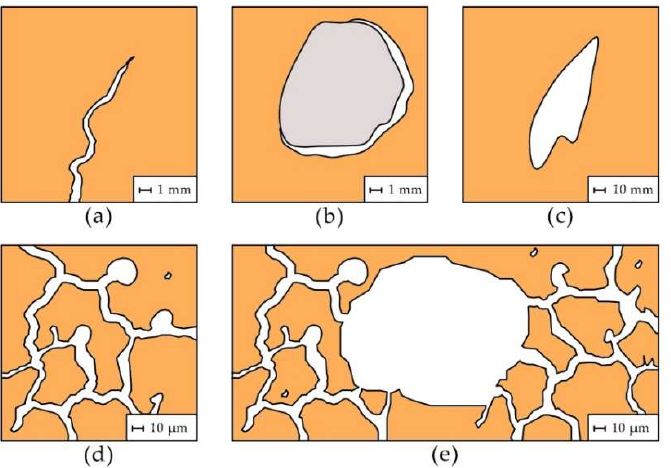
Figure 18. Pore diagram: ( a )—cracks and fissures, ( b )—voids around inclusions, ( c )—voids resulting from under-densification of the material, ( d )—pores connected to pores of similar diameters, ( e )—pores that are distributed uniformly in the sample space, connected to pores of much smaller diameters.